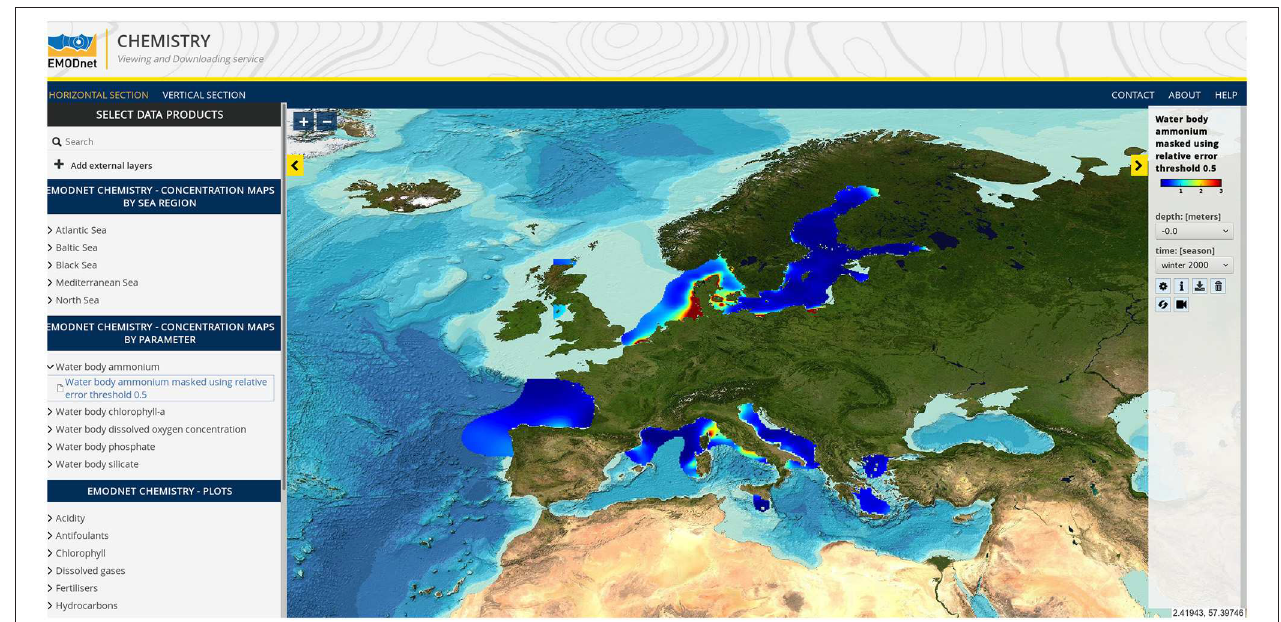
FIGURE 3 | Products: global interpolated maps for Ammonium in the water column, winter